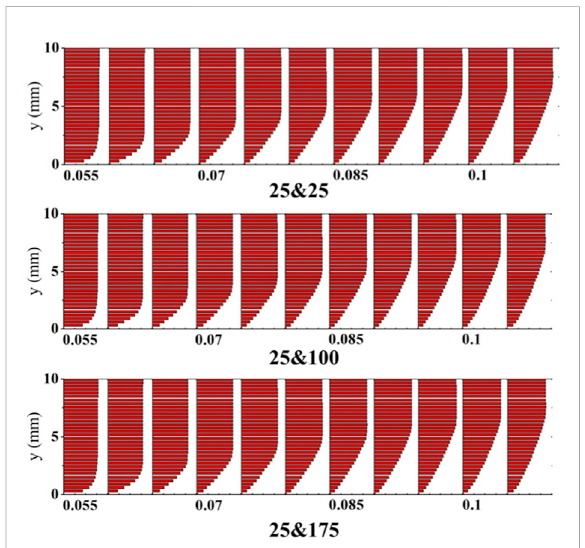
FIGURE 11 Velocity distributions in the near wall region for various models in Test 1 ( F =